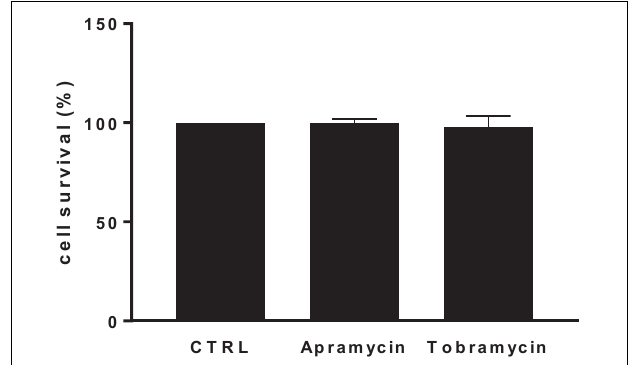
FIGURE 7 | In vitro cytotoxicity against IB3-1 cells. IB3-1 cell monolayers were exposed for 24 h to apramycin and tobramycin at 512 mg/L. Control cells were not treated. At the end of incubation, the cell viability was assessed using an MTS tetrazolium-based colorimetric assay. Results are shown as mean + SD of the survival rate vs. control cells (CTRL, 100% cell survival). No statistically significant difference was found at Fisher’s exact